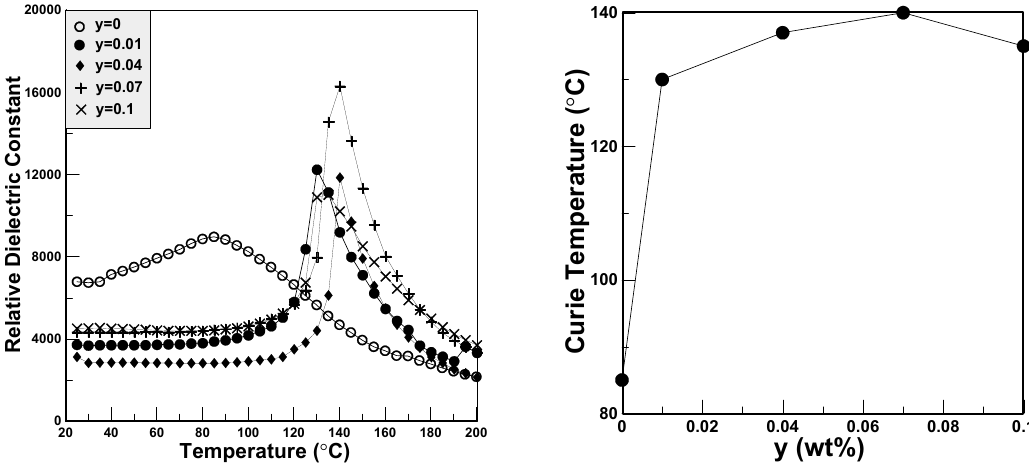
Figure 8. The Curie temperature of the BCTS–yLiF sheets.